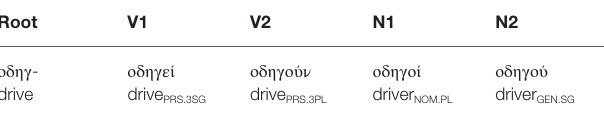
TABLE 2 | An example of verbs and nouns in a quadruplet of Experiments